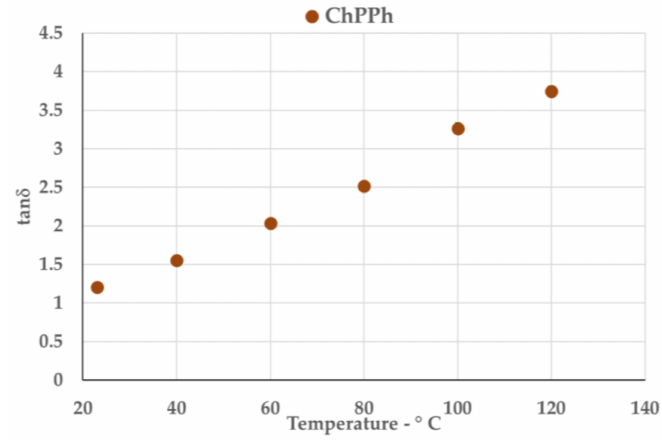
Figure 10. Variation of tan δ (@2.45 GHz) according to temperature for